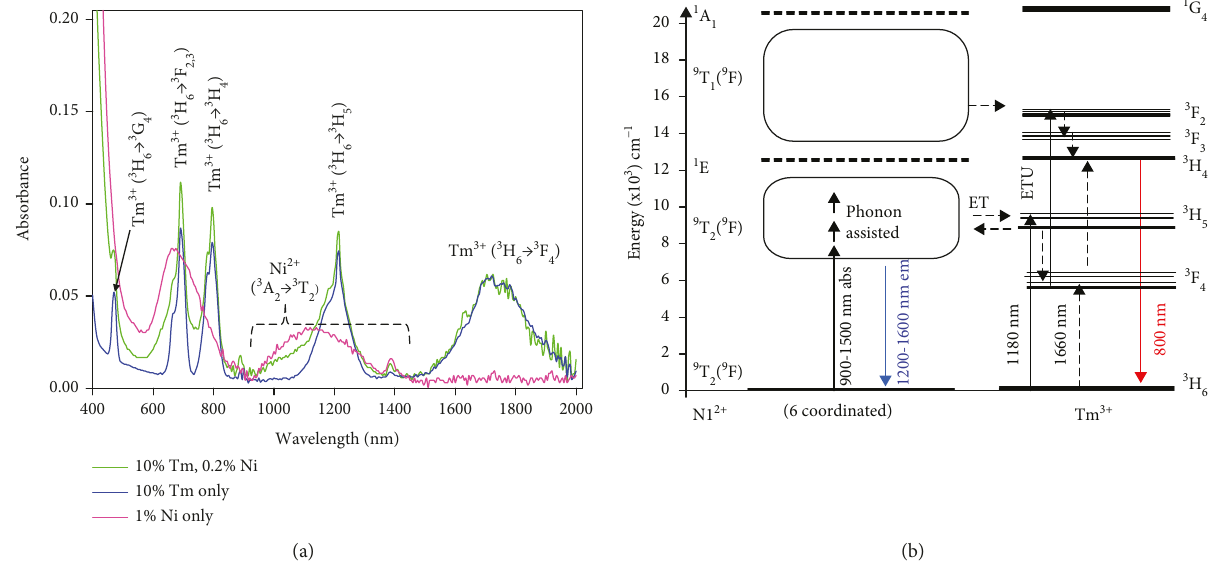
Figure 1: (a) Absorption spectra and (b) energy level diagram of the Ni 2+ and Tm 3+ ions in the CaTi transfer